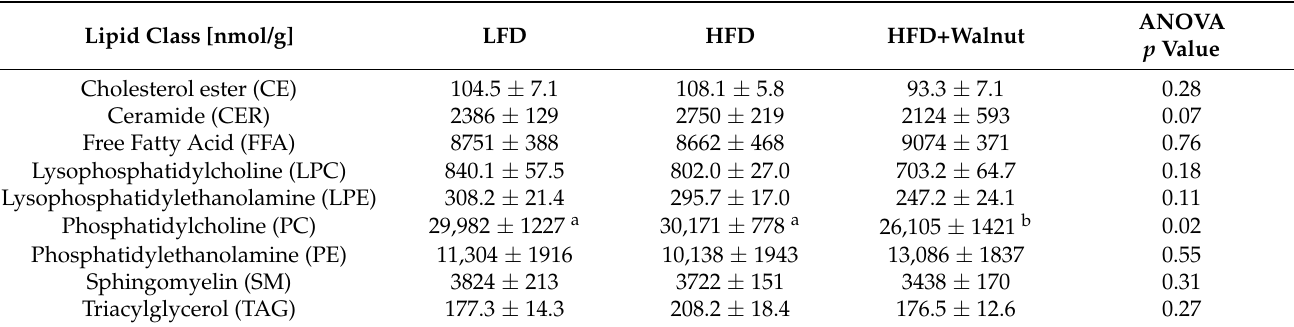
Table 2. Concentration of lipid classes in